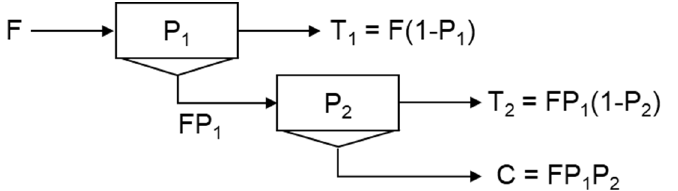
Figure 3. Example of linear circuit analysis. F is the feed rate, T 1 the sunk product rate, P 1 and P 2 the recovery for each unit bank, and C the concentrate rate.